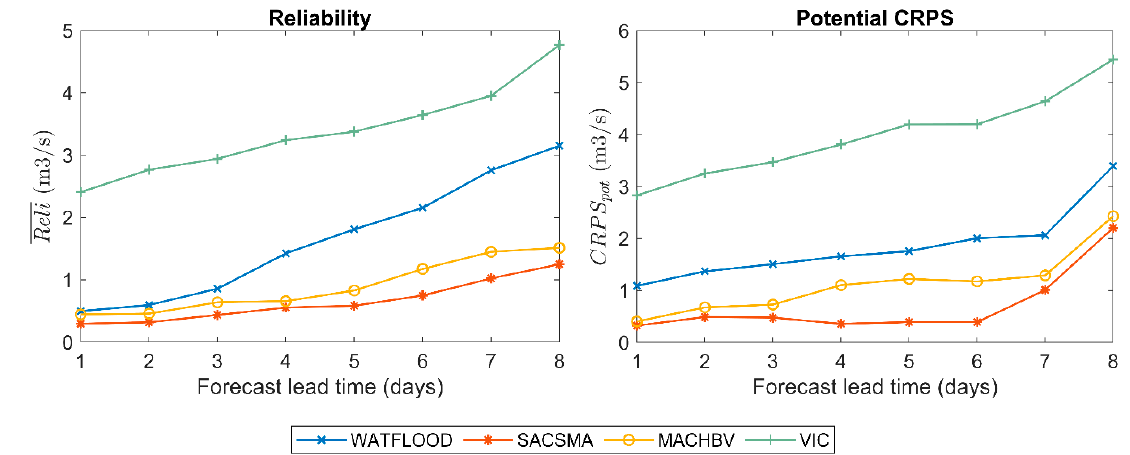
Figure 8. CRPS decomposition components. The left plot shows the reliability component, and the right plot shows the Potential CRPS component. A comparison of these attributes was made between four hydrological models.